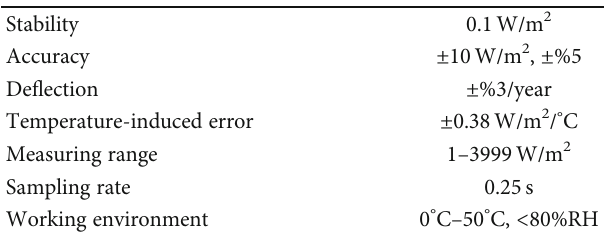
Figure 7: The position of the pyranometer on the collector. Table 5: Technical features of the pyranometer used in the experiment.